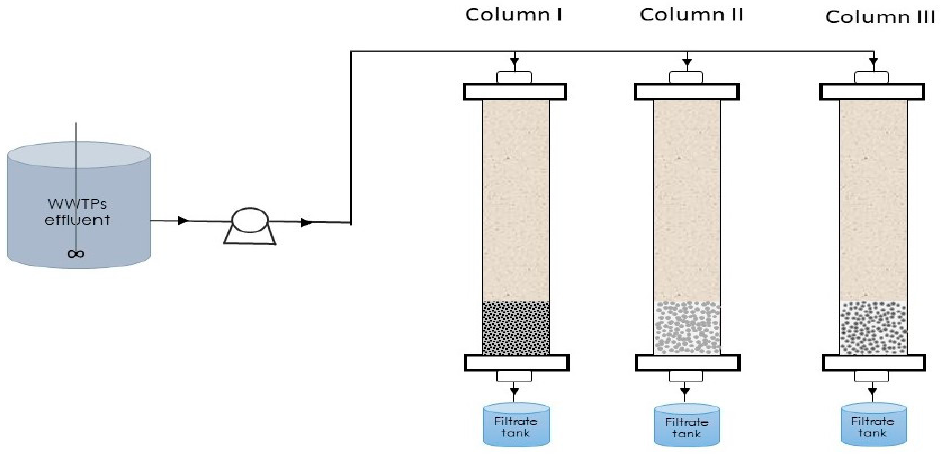
Figure 1. Fixed bed columns setup. Table 3. Loadings of the columns.